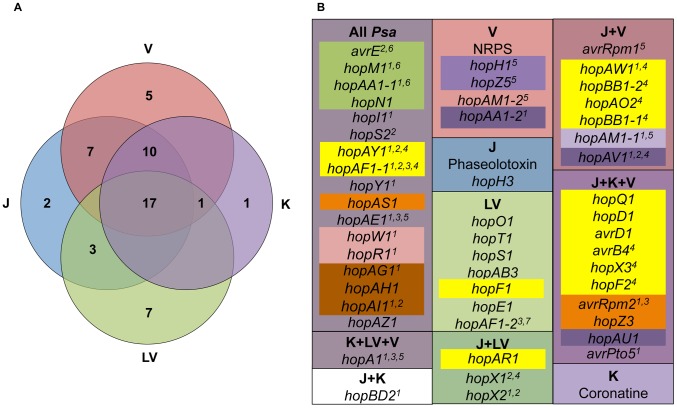
Type 3 secreted effector and toxin distribution in Psa clades.The numbers inside each region of the Venn diagram represent T3SEs with orthologs present in the low-virulent (LV), Korean (K), Japanese (J) and recent global outbreak (V) clades (A). The outer boxes in B reflect the clade-specific distribution of T3SEs (italicized) and toxins, while the color of the internal text boxes refers to their occurrence on genomic islands. 1premature terminations, partial translocations, frame shifts, and out of frame indels in some strains. 2variation between alleles (>2% variation, in frame fusions/indels). 3indicates the T3SE may not be in all Psa K strains. 4indicates the T3SE may not be in all Psa J strains. 5T3SE that occur within a transposon region. 6T3SE is present in the conserved effector locus. 7LV has two effectors in the HopAF1 group, HopAF1-2 is most closely related to HopAF1-1 in the Korean clade while HopAF1-1 is most closely related to HopAF1-1 in the outbreak and Japanese clades.